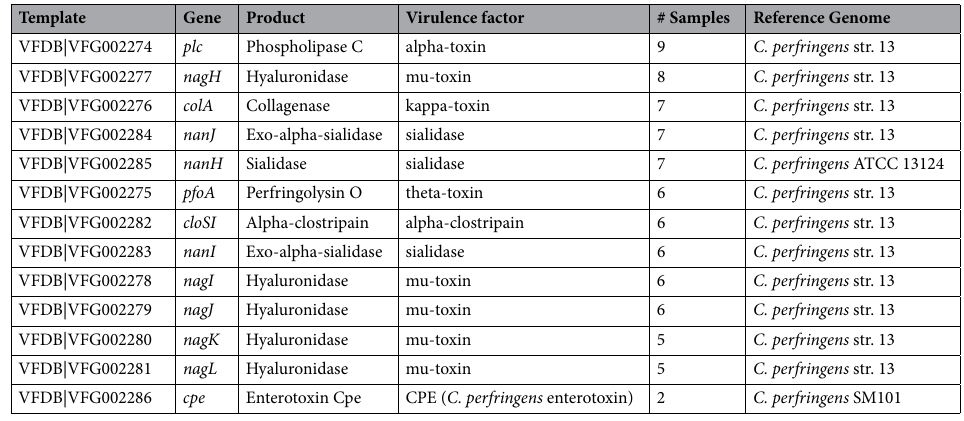
Table 2. Clostridium perfringens virulence factors detected in PATRIC.